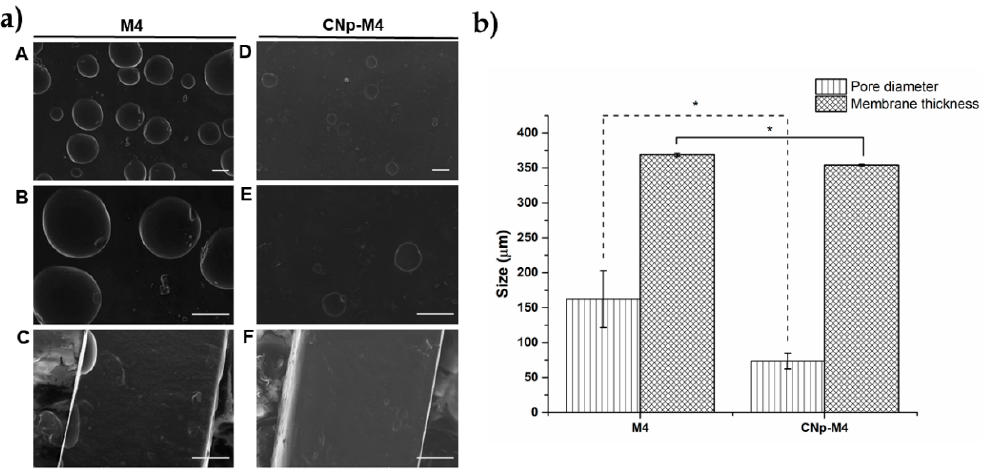
Figure 5. Morphology and porosity of alginate membranes. ( a ) Micrographs by scanning electronic microscopy of the alginate membrane surface (A, B, D, and E) and membrane thickness (C and F). Magnification of 100 × for A, D; 220 × in B, C, E and F; the scale bar is 100 µ m; ( b ) pore diameter and membrane thickness of M4 and CNp-M4 membranes, mean ± SE, n = 3. * indicates that p < 0.05 is statistically significant.